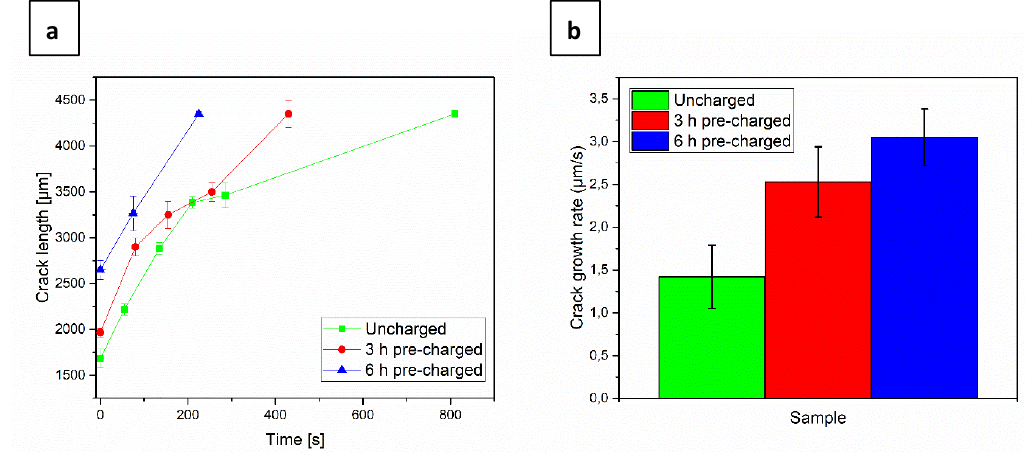
Figure 8. ( a ) Normalized crack length evolution; ( b ) crack growth rate of the uncharged, 3 h pre-charged and 6 h pre-charged CP steel samples. Materials 2020 , 13 , x